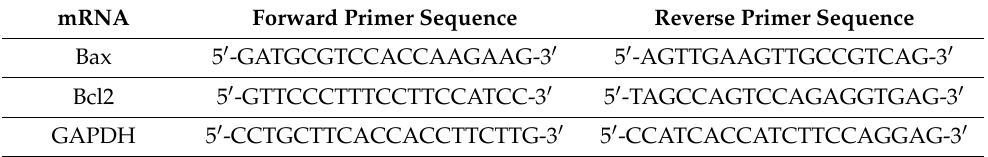
Table 1. Primers used for real-time PCR